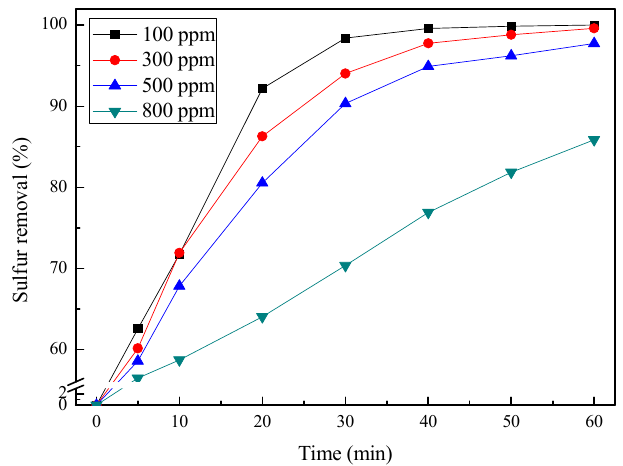
Figure 8. The effect of initial sulfur concentration on DBT removal. Experimental conditions: catalyst dosage, 2.5 wt.% of n -octane; temperature, 0 °C; ozone dosage, 0.1 g/h.